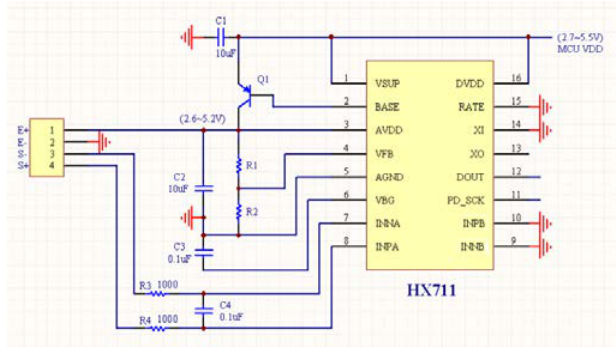
Fig. 4 . Schematic of HX711.